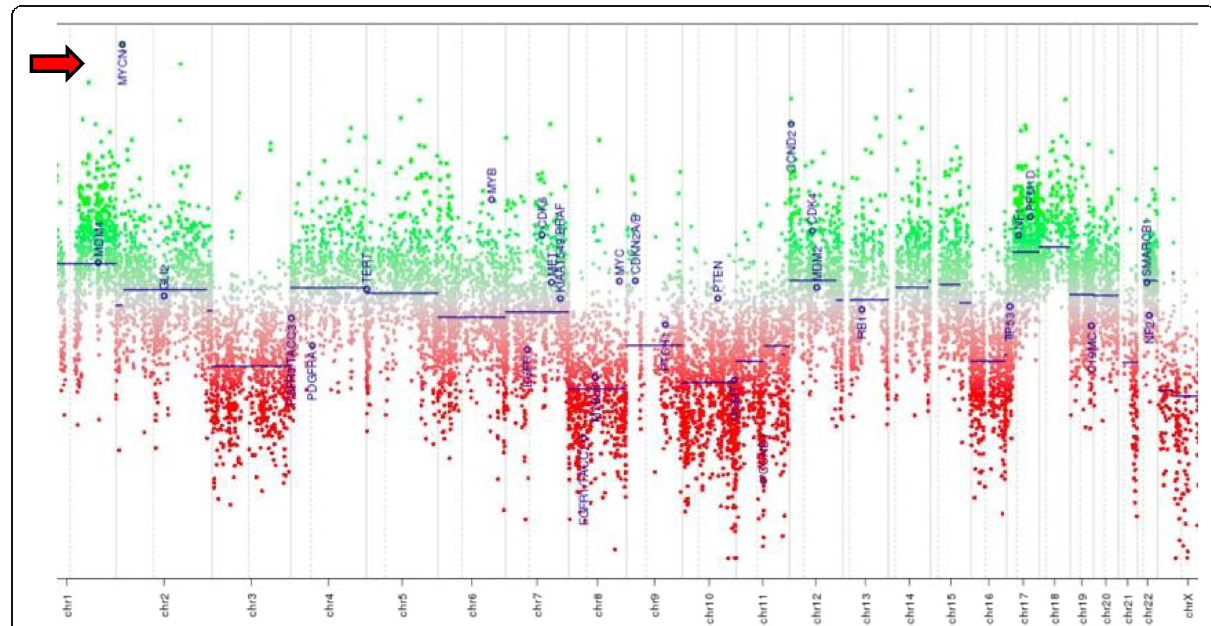
Fig. 5 Methylation analysis for copy numbers analysis. Depiction of chromosome 1 to 22 (and X/Y if automatic prediction was successful). Gains/ amplifications represent positive, losses negative deviations from the baseline. 29 brain tumor relevant gene regions are highlighted for easier assessment. Arrow highlights MYCN